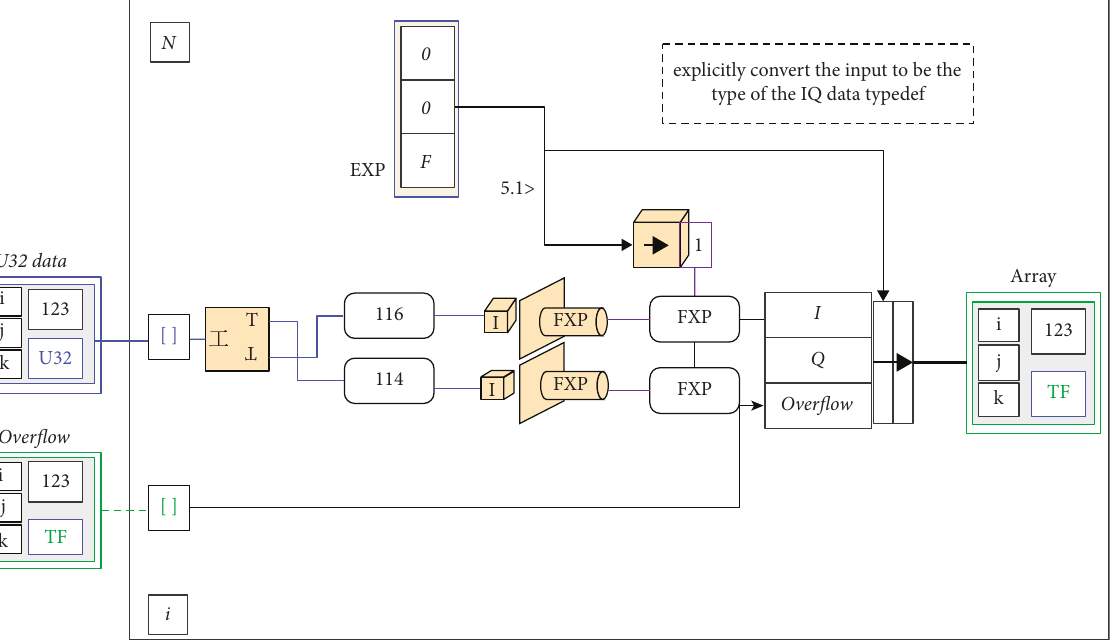
Figure 7: The process of converting a real signal into an IQ